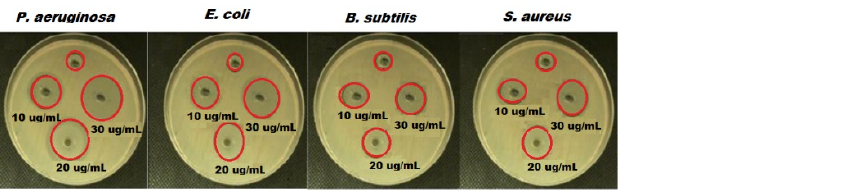
Figure 7. Antibacterial activity of different concentrations of green synthesized ZnONPs using oat biomass against four bacterial strains; the positive control was 25 µg mL − 1 of tetracycline and the negative control was Milli-Q water.